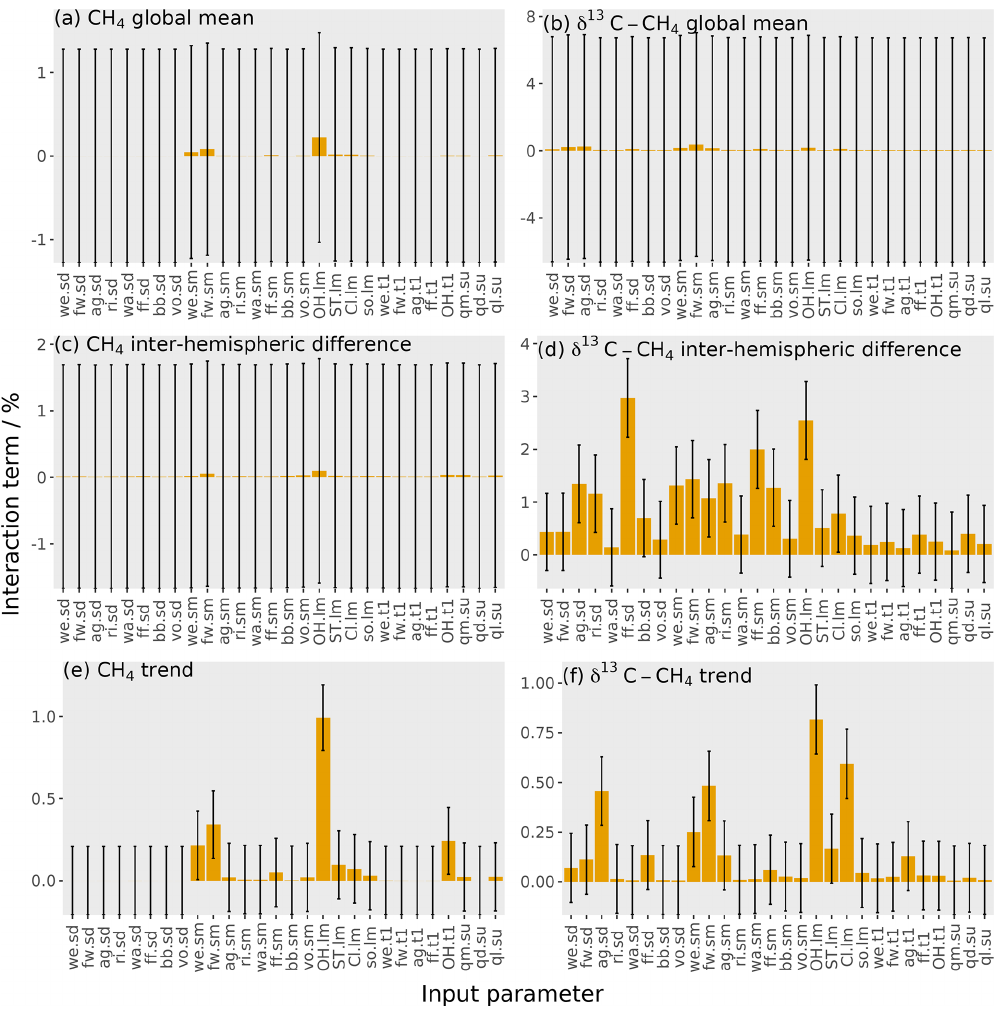
Figure 8. The orange bars show the interaction terms of the parameters, with the error bars showing the uncertainty in these interactions (calculated using bootstrap resampling; see Supplement). Each panel shows one output: (a) mole fraction global mean, (b) δ 13 C–CH 4 global mean, (c) mole fraction inter-hemispheric difference, (d) δ 13 C–CH 4 inter-hemispheric difference, (e) mole fraction trend, and (f) δ 13 C–CH 4 trend. The values given here are for the temporal mean of the time series. The input parameter codes are given by a combination of a two- character code giving the source or loss (wetlands, we; fresh water, fw; agriculture, ag; rice, ri; waste, wa; fossil fuels, ff; biomass burning, bb; volcanoes, vo; hydroxyl radical, OH; stratospheric, ST; Cl radical, Cl; soil, so; total source magnitude, qm; total source δ 13 C–CH 4 signature, qd; total loss imbalance, ql) and another code giving the type of parameter (source δ 13 C–CH 4 signature, sd; source magnitude, sm; loss magnitude, lm; temporal trend, t1; spin-up,